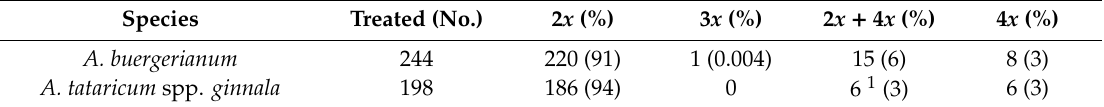
Table 4. Ploidy of seedlings of Acer buergerianum (trident maple) and A. tataricum ssp. ginnala (Amur maple) treated during 2012, for 5 d with 25 µ L of 150 µ M oryzalin supplied as Surflan + 0.55% agar applied to meristems at the first true leaf stage.